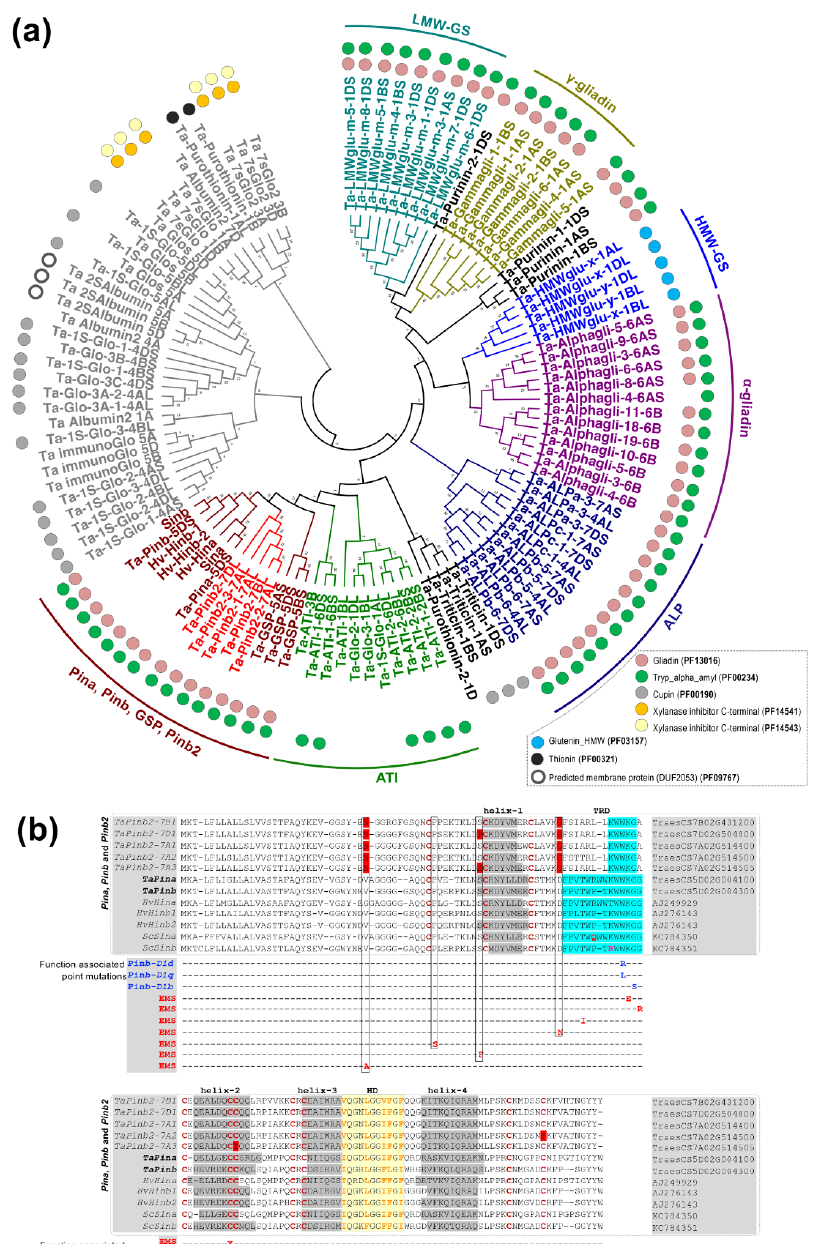
Figure 2. Analyses of phylogeny and protein sequence alignment for PINB2, together with other wheat seed proteins. ( a ) Maximum likelihood (ML) phylogeny of HMW-GS, LMW-GS, α -gliadin, γ -gliadin, purinin, purothionin, avenin-like proteins (ALPs), PINA, PINB and GSP from the bread wheat CS and the homologous proteins of PINA, PINB and GSP from triticale and barley. Results for protein domain analysis using profile hidden Markov Models (HMMER) are shown as color-coded circles. ( b ) Alignment of the amino acid sequences between PINA, PINB, GSP, PINB2, from wheat, barley and triticale, highlights that PINB2 proteins share the cysteine residue backbone, five α-helixes and hydrophobic domain with PINs but lack TRD domain. PINB2 proteins also contain some changes in the conserved amino acids that are important for PINs’ function in kernel hardness (those amino acids shaded in red for PINB2 proteins). α-helixes, hydrophobic domain and TRD are shaded in grey, yellow and blue, respectively. The cysteine residues are shown in red.